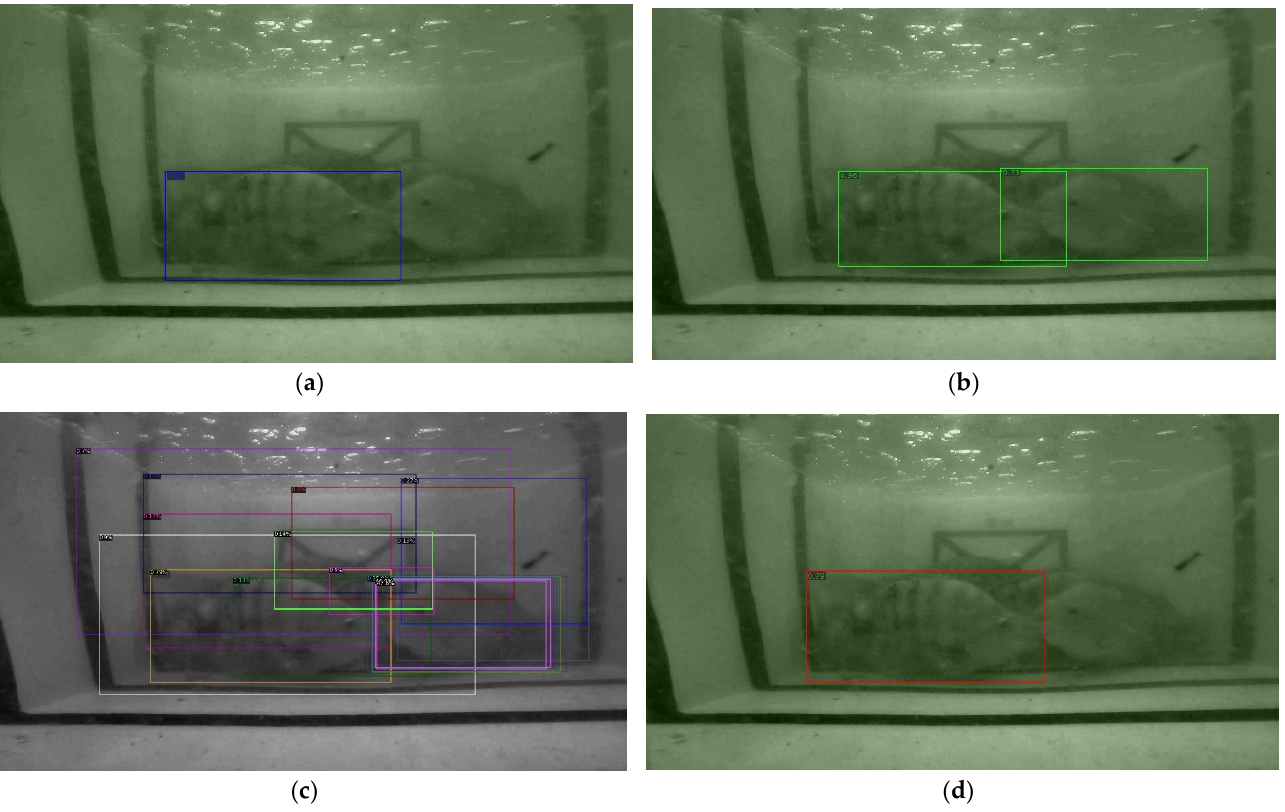
Figure 8. Sample of two Tilapia with more than 50% of a body size appearance. ( a ) Faster R-CNN: model detected a Tilapia with 0.88 probability score; ( b ) Mask R-CNN: model detected a Tilapia with 0.96 and 0.73 probability scores from left to right; ( c , d ) RetinaNet: model drew 28 bounding boxes with the highest, average, and standard deviation of probability scores at 0.79, 0.13, and 0.15, respectively.